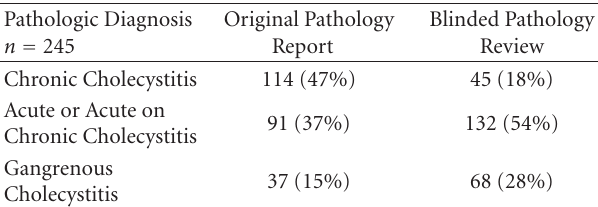
Table 2: Pathology review results.